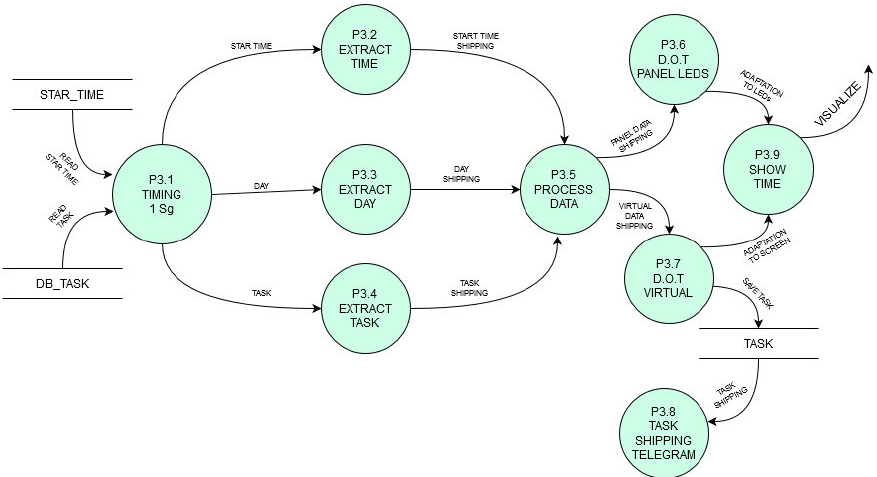
Figure 9. Second level in DFD format for TO service with a virtualized display.